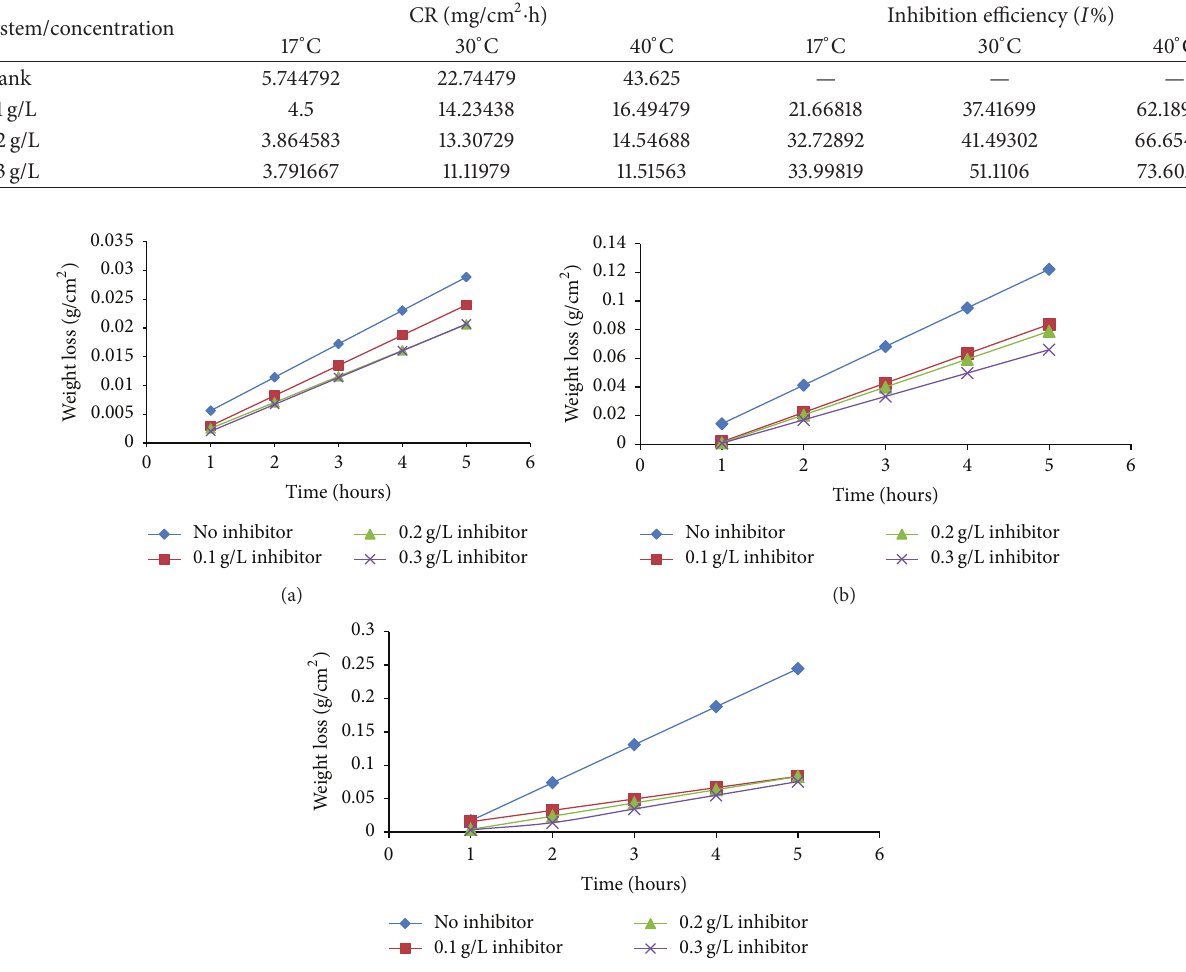
Table 2: CR and inhibition efficiency ( 𝐼 %) of mild steel in 1MHCl for various inhibitor concentrations at various temperatures. System/concentration